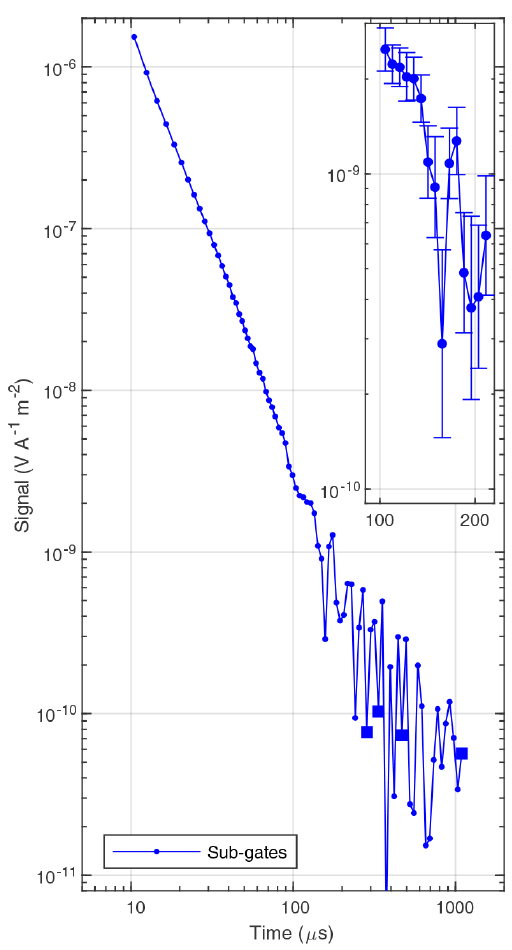
Figure 3. Sounding curve from the Gedved survey consisting of 81 boxcar-shaped sub-gates. For negatively valued sub-gates, the absolute value is plotted and indicated with a square marker. From approximately 100µs and onwards the data are dominated by VLF noise and oscillates. The inset shows values and standard errors for sub-gates between 100 and